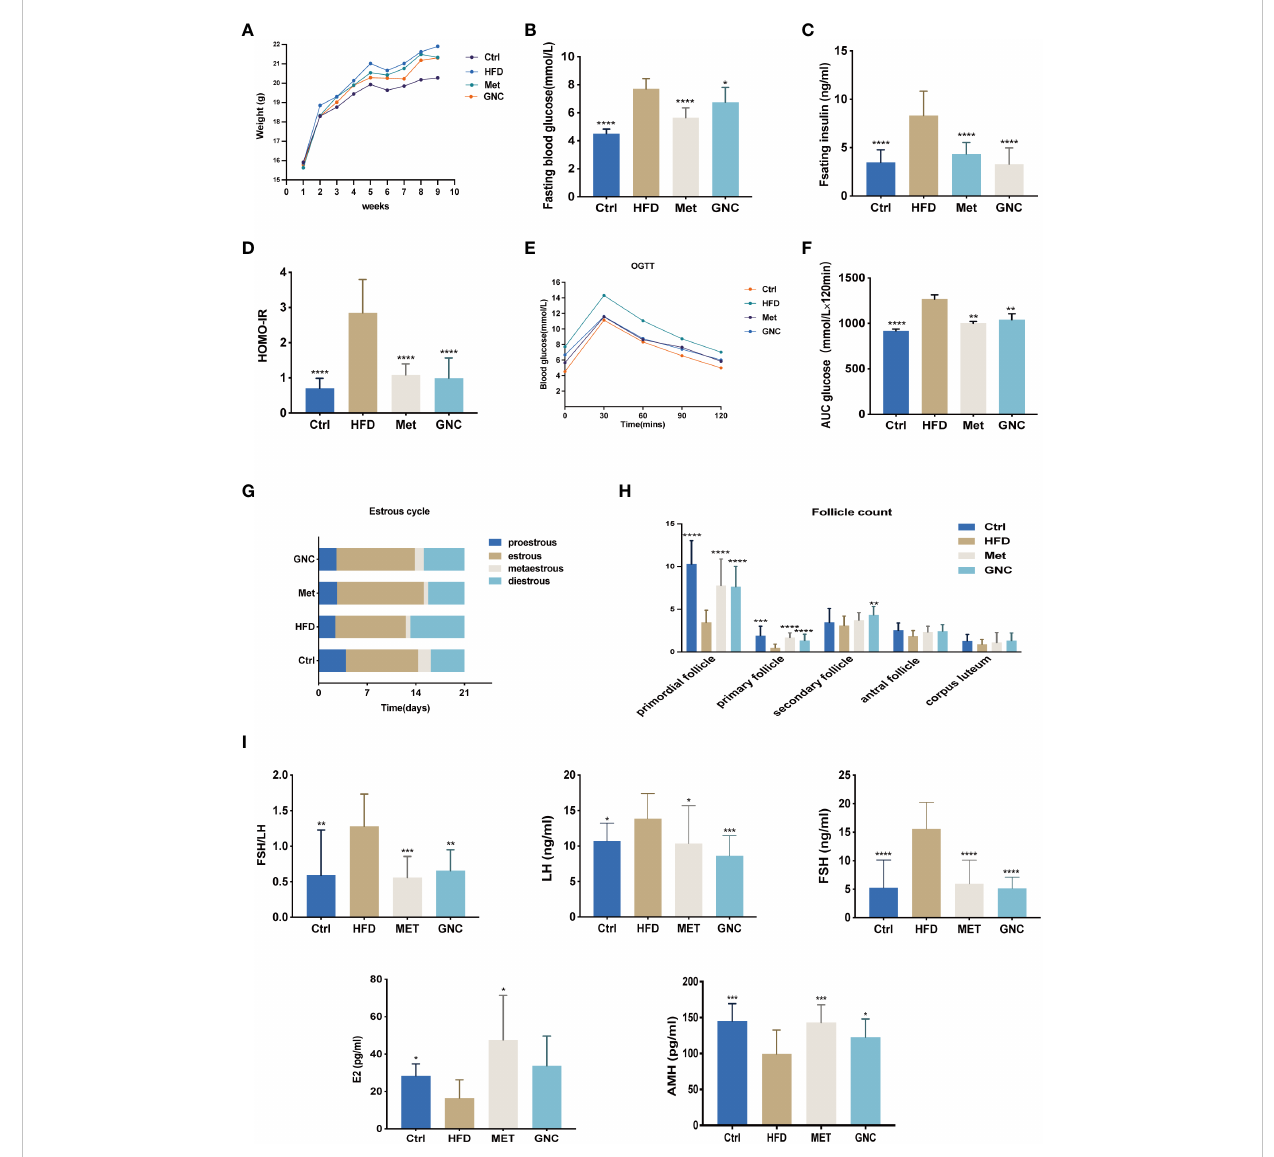
FIGURE 7 Gengnianchun reversed both HFD induced-insulin resistance and decreased ovarian function. (A) Weight of mice in the control group (Ctrl), HFD-fed group (HFD), Metformin group (Met), and Gengnianchun-fed group (GNC). (B – F) Fasting blood glucose, HOMA-IR, OGTT, and area under the curve (AUC) of mice in each group were assessed after a 12 – 14-h fast. (E – G) Different stages of the estrus cycle were assessed by collecting vaginal smears at same time point every day. Estrus cycle was assessed every day for the last 3 weeks, n=14 with one repeat in each assay. (H) Detailed counting offollicles at different stages, n=14 with one repeat in each assay; t-test. (I) Serum FSH, LH, E2, AMH, and fasting insulin were determined by ELISA with a 12 – 14-h fast before sacri fi ce; FSH/LH was calculated, n=14 with one repeat in each assay; *: P<0.05, **: P<0.01, ***: P<0.001, ****: P<0.0001 compared to group “ Ctrl ”